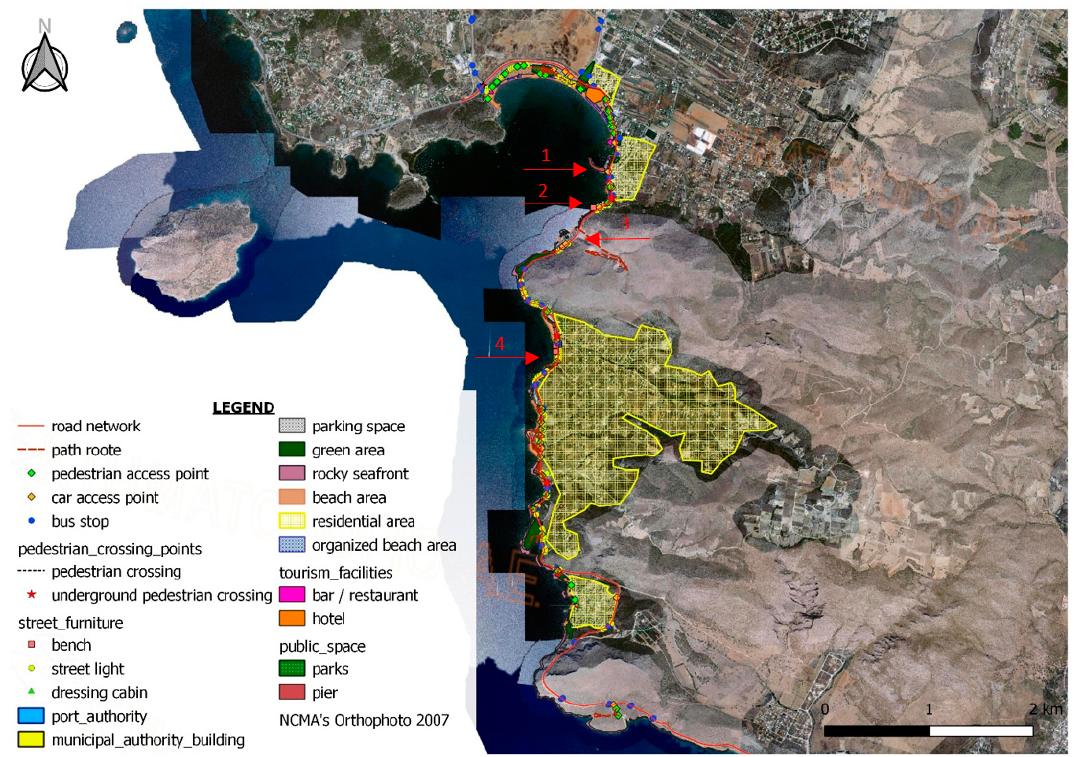
Figure 6. Final edited map of the collected geospatial information of the pilot case study area. Source: own elaboration.